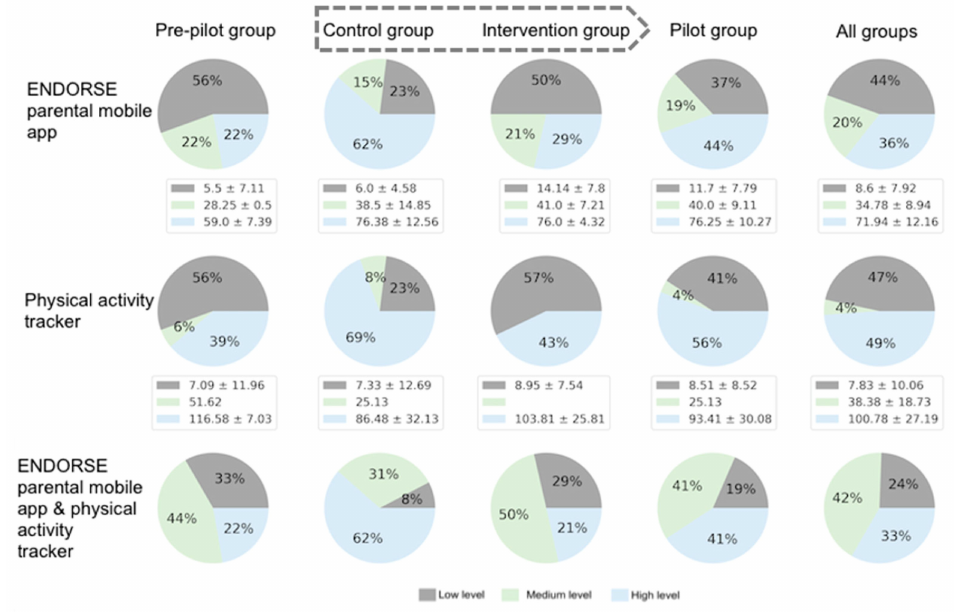
Figure 5. Level and score of adherence. Each pie chart depicts the percentage of participants in each corresponding level, while the respective scores of adherence are presented as legends in terms of mean and standard deviation. Some pie charts don’t add up to 100% due to periodic numbers